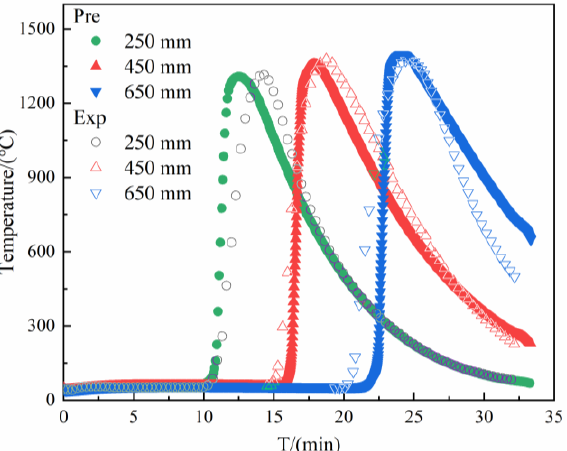
Figure 4. The actual size distribution of granules in the vertical direction of the bed. Table 4. Dimensions and parameter values used for the numerical model.